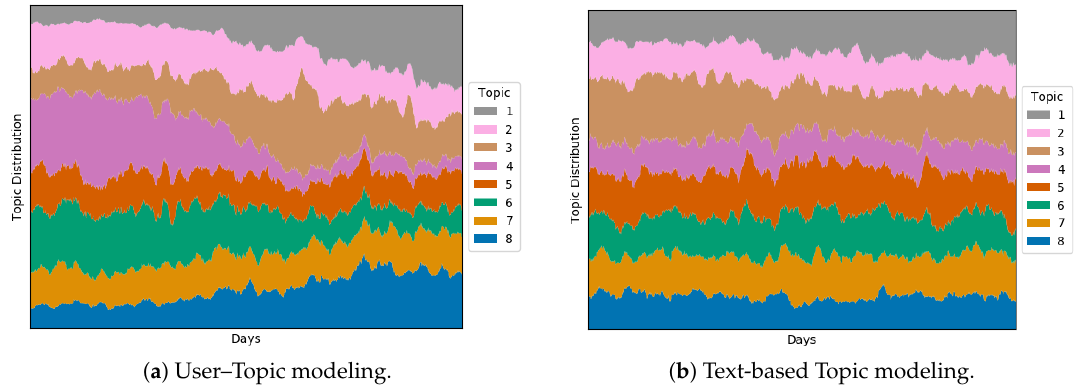
Figure 3. Comparison of user–topic and text-topic modeling methods in the Slashdot